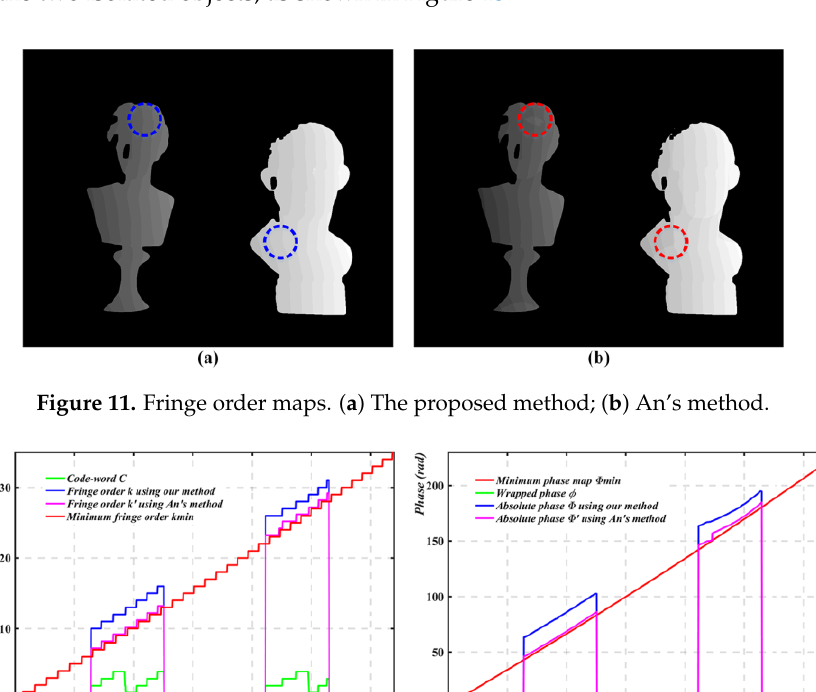
Figure 12. The 600th rows. ( a ) Fringe order maps; ( b ) absolute phase maps.